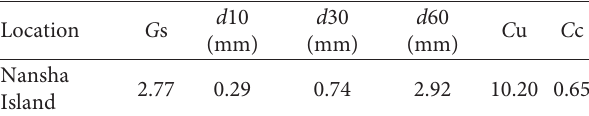
Figure 2: Grain size distribution curve of calcareous sand. Table 1: Physical parameters of calcareous sand.